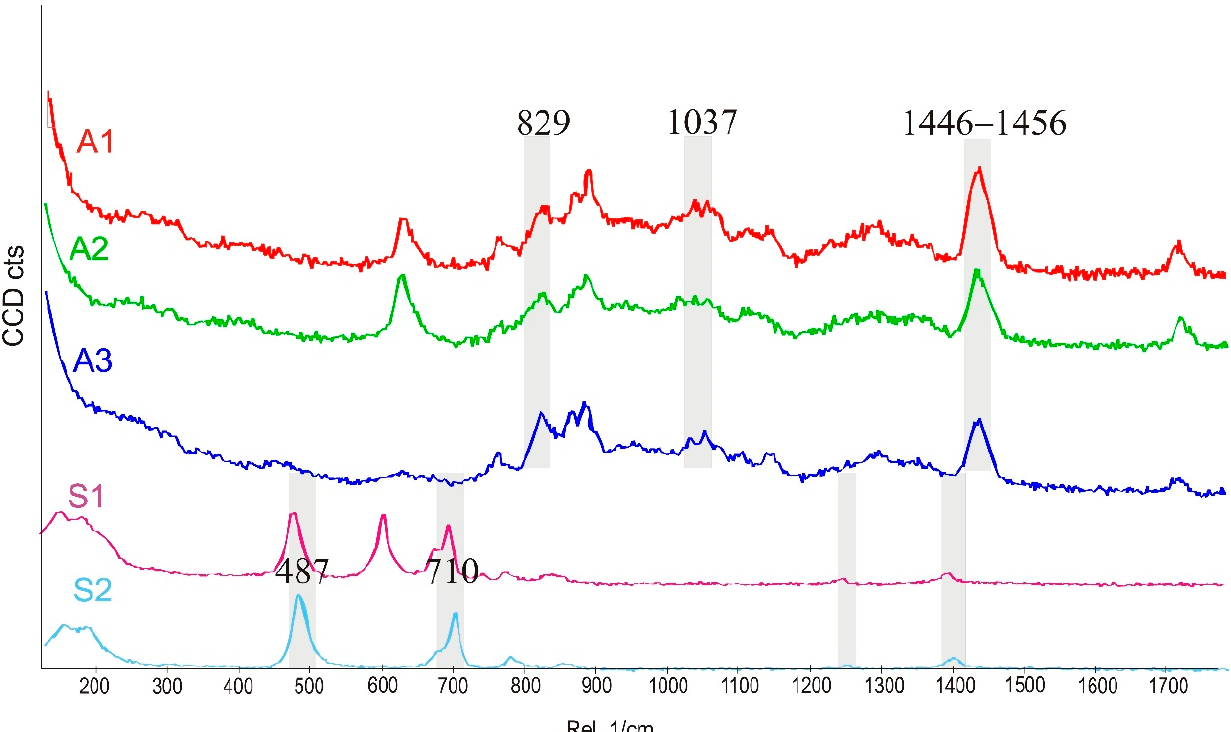
Figure 3. Raman spectra of placebo patches: polyacrylates (A1–A3) and polysiloxanes (S1, S2). The grey bands mark differences or similarities between the spectra of the polymers.